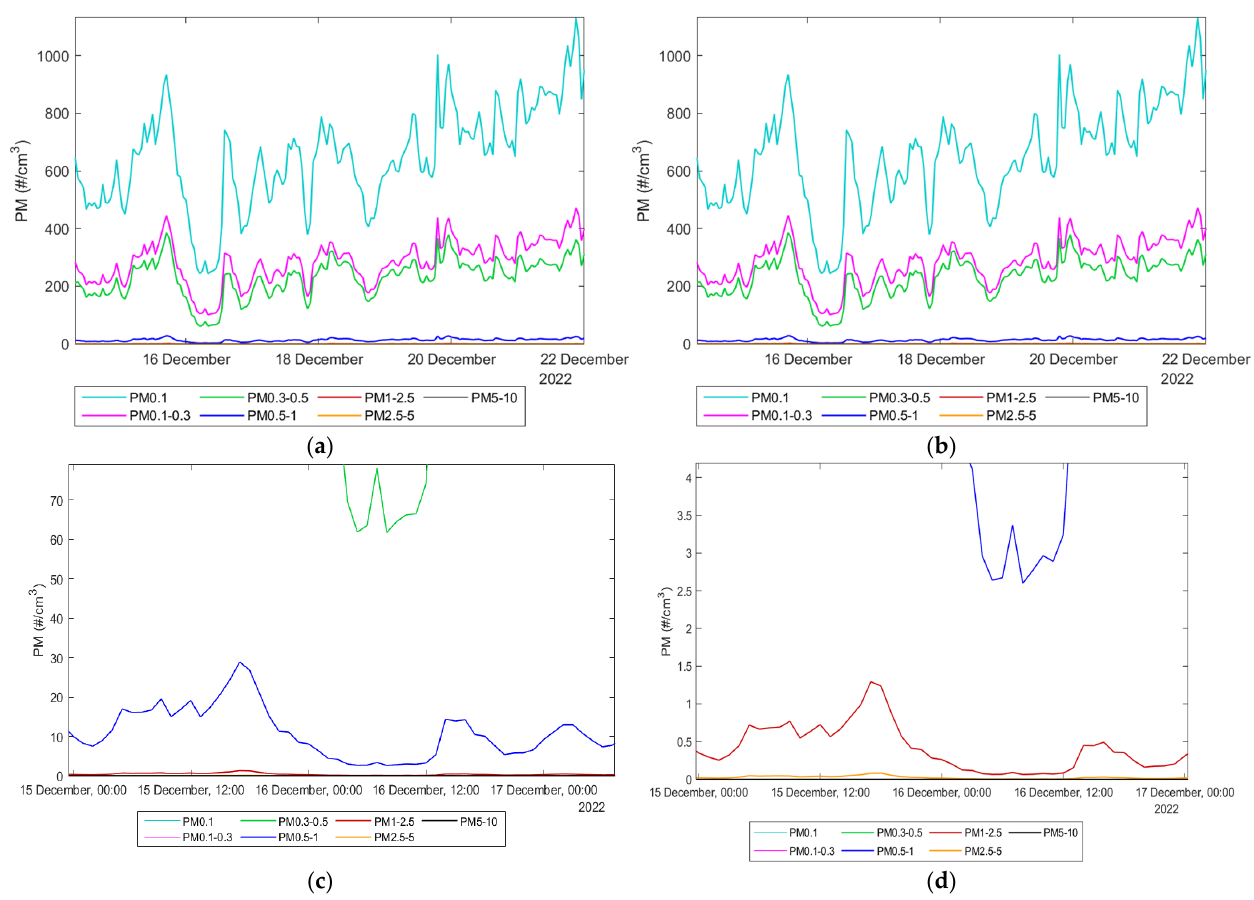
Figure 12. Non-cumulative number concentrations of PM measured by IPS-7100: ( a ) hourly averages of PM0.1 (cyan), PM0.1–0.3 (magenta), PM0.3–0.5 (green), PM0.5–1 (blue), PM1–2.5 (red), PM2.5–5 (yellow), PM5–10 (black) and the ( b – d ) close-ups for better illustrations of all categories.